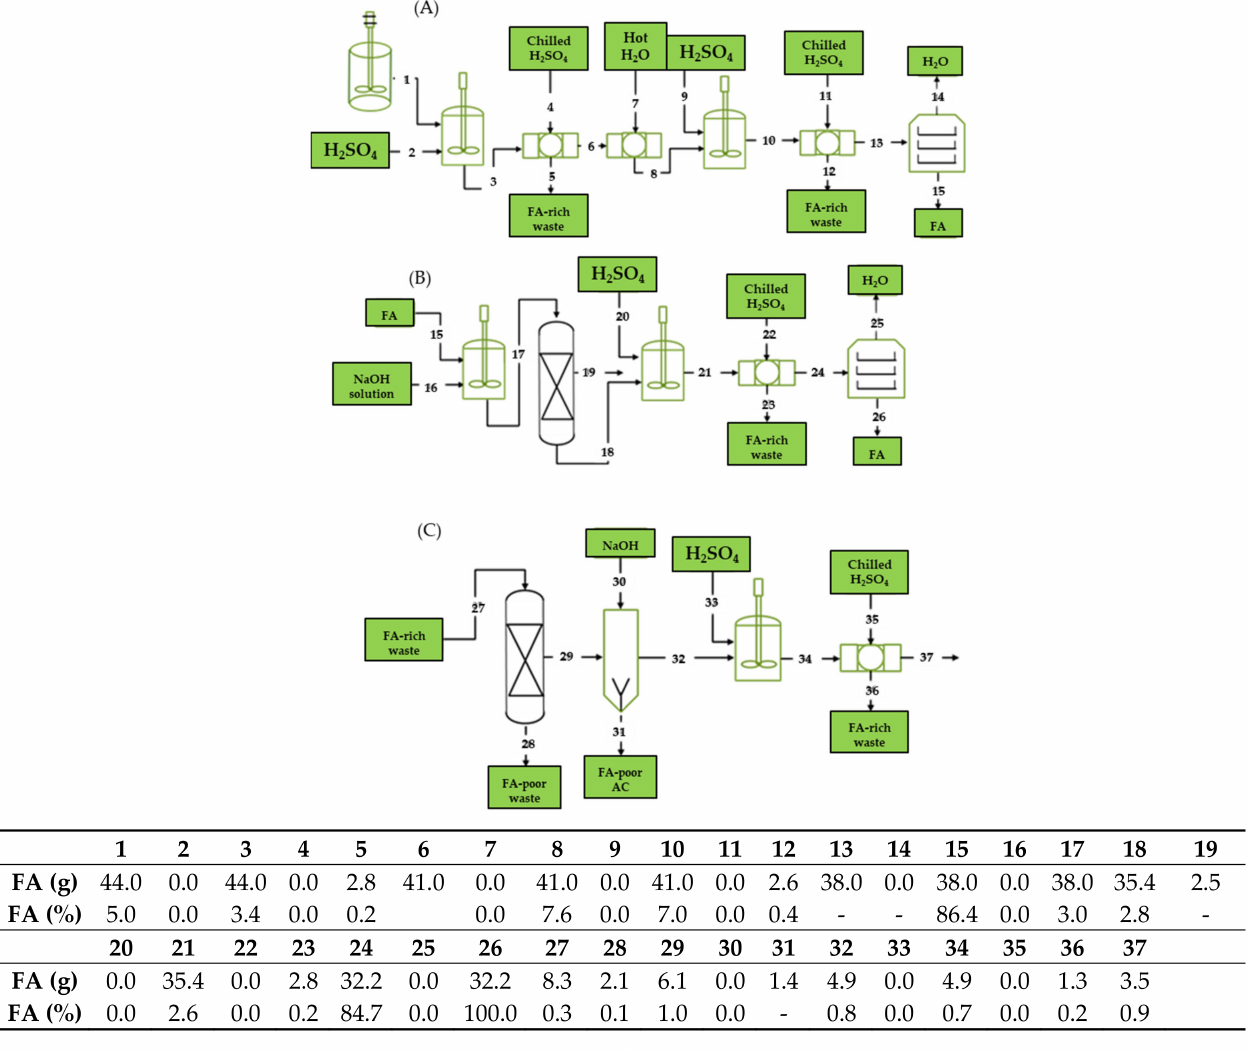
Figure 2. Process flow diagram and mass balance of fumaric acid (FA) obtained after ( A ) a two-stage precipitation process, ( B ) a polishing step, and ( C ) recovery of FA residue from liquid waste